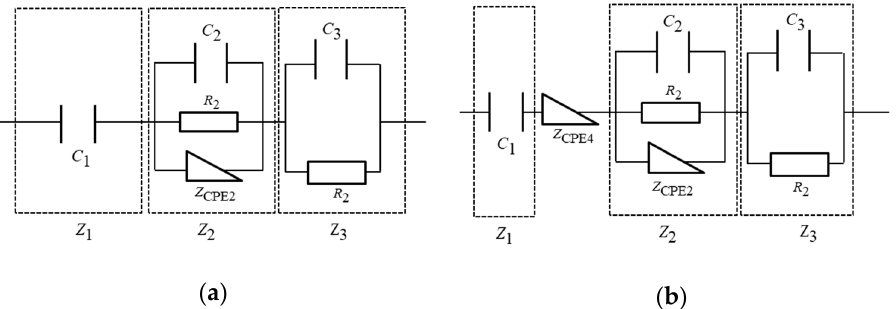
Figure 5. The equivalent circuit analysis of the degraded EDLCs. ( a ) The equivalent circuit analysis results for the real part capacitance of the degraded EDLCs. ( b ) The equivalent circuit analysis results for the imaginary part capacitance of the degraded EDLCs.